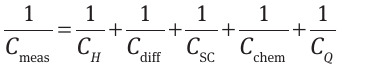
Figure 2: While the constituent charge in the individual layers of a 2D material may be considered discrete, the carrier concentration from the outermost layer into the current collector may be modeled through a continuous exponential decay. A concomitant length scale for the internal charge storage would be an equivalent Thomas- Fermi screening length [26] ( λ ). Additionally, immobile surface T - F charges (due to defects) may also contribute to the space charge. (Figure adapted from Reference [27] and reproduced with permis- sion from the American Chemical Society,